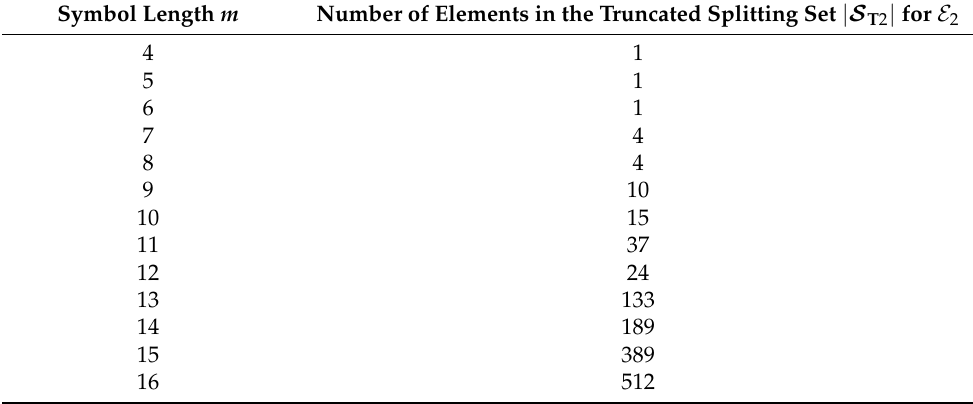
Table 3. The cardinality of the truncated splitting sets S T2 for E 2